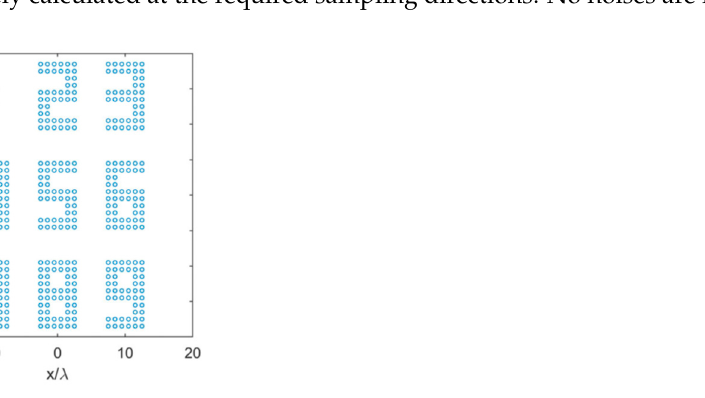
Figure 3. Source picture to reconstruct. Here, 364 Hertzian dipoles locate on the xoy plane. Each dot represents a dipole.